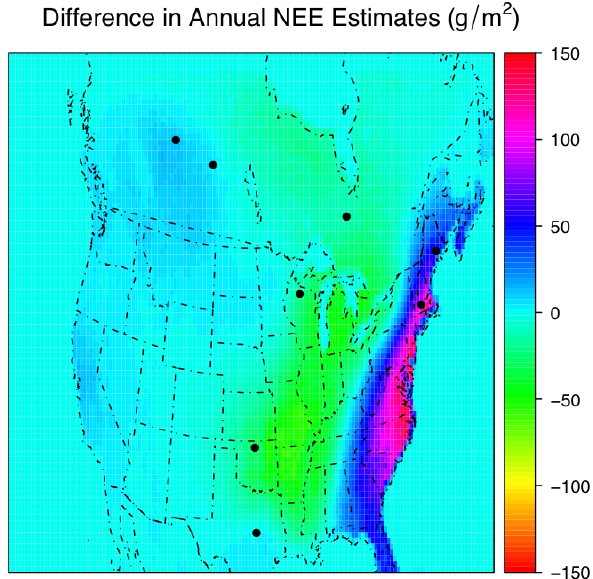
Figure 8: Difference in annual sink inferred by Fig. 8. Difference in annual sink inferred by inversions based upon inversions based upon the Vulcan fossil fuel inventory the Vulcan fossil fuel inventory and the Andres et al. (1995) fos- and the Andres et al. [1995] fossil fuel inventory. sil fuel inventory. Positive values (purple) indicate carbon sinks Positive values (purple) indicate carbon sinks were were stronger using Andres inventory. Spatially-summed annual stronger using Andres inventory. Spatially-summed difference between Vulcan-based NEE estimate for 2004 and An- annual difference between Vulcan-based NEE dres (1995) based NEE estimate for 2004 is less than estimate for 2004 and Andres[1995] based NEE estimate for 2004 is less than 0.01 PgC.